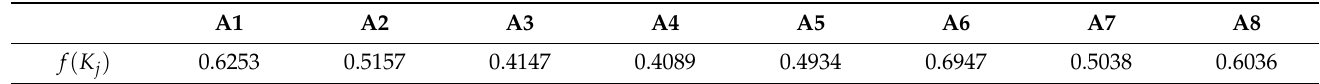
Table 7. The final utility function of market-oriented business regulatory risks.